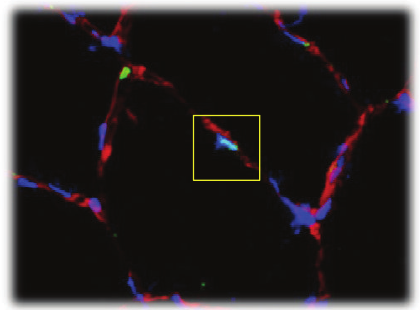
Figure 5: Pax7 positive cell (satellite cell) inside the yellow square. Red stain: laminin, green stain: Pax7, and blue stain: DAPI (nuclei).